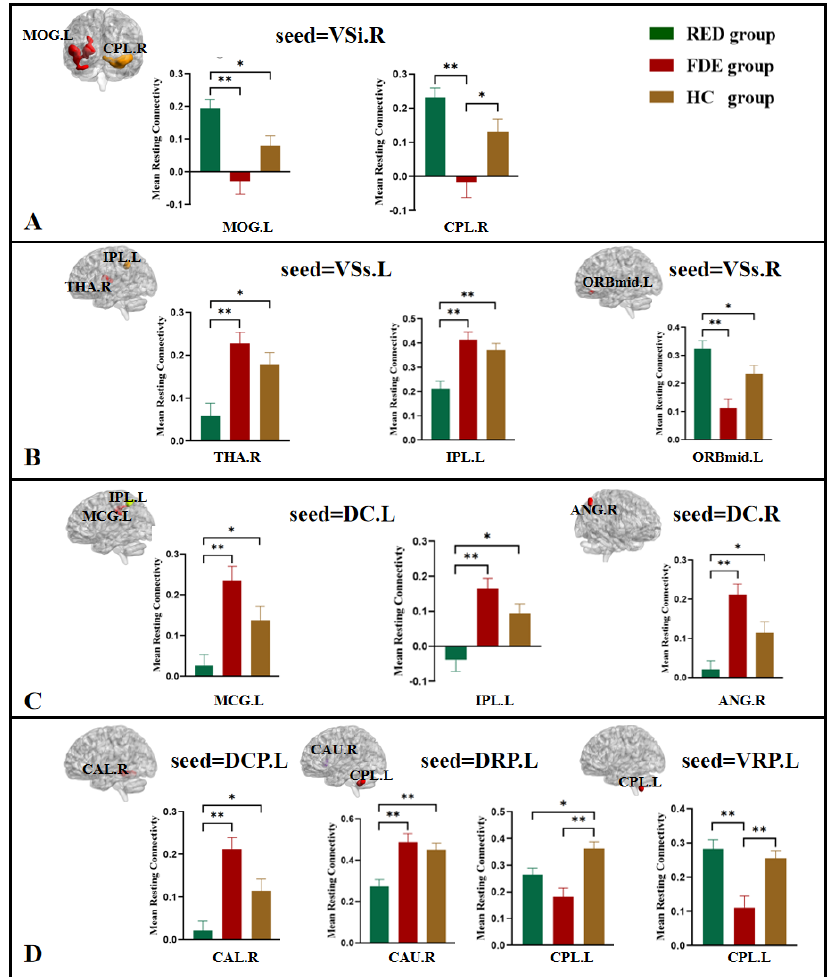
Figure 2. Brain regions with abnormal FC of the striatal subregion among the three groups based on one-way analysis of variance. The color bars indicate the F -value. L, left; R, right; VSs, superior ventral striatum; VSi, inferior ventral striatum; DC, dorsal caudate; DRP, dorsal rostral putamen; DCP, dorsal caudal putamen; VRP, ventral rostral putamen. ( A ), seed of the right VSi; ( B ), seed of the left VSs; ( C ), seed of the right VSs; ( D ), seed of the left DC; ( E ), seed of the right DC; ( F ), seed of the left DCP; ( G ), seed of the left DRP; ( H ), seed of the left VRP.